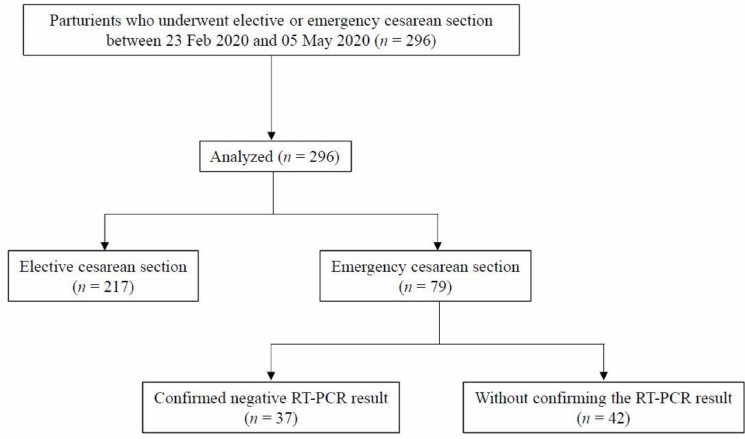
Figure 4. Flow diagram for analysis of